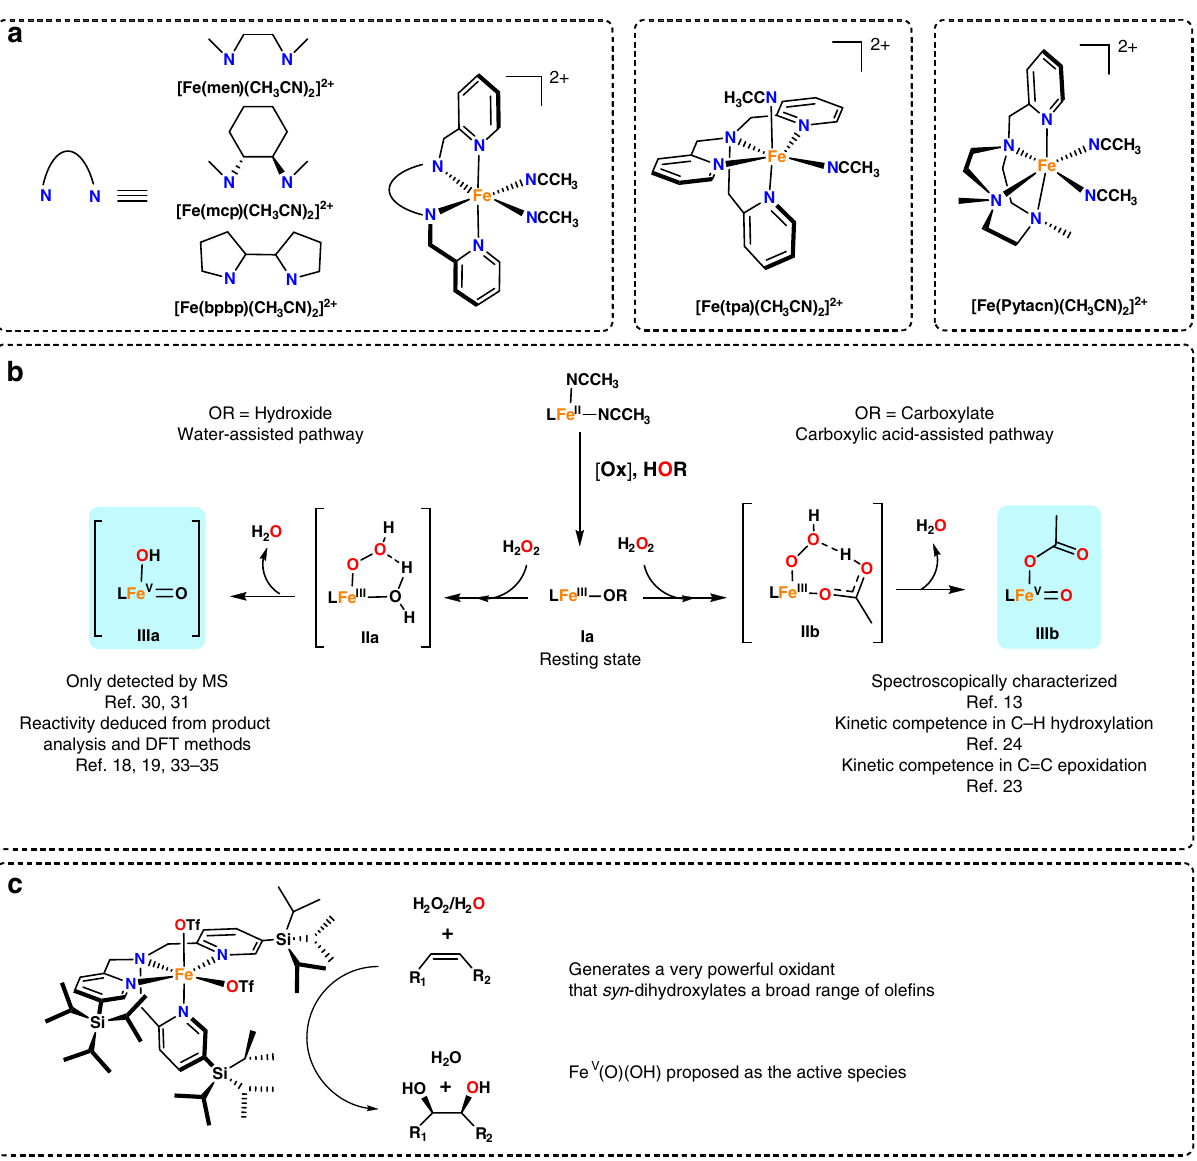
Fig. 1 Mechanistic frame of iron-catalyzed oxidations with tetradentate aminopyridine ligands. a Iron catalysts based on tetradentate aminopyridine ligands that catalyze stereoretentive C – H and C = C oxidations. b Mechanistic frame for the generation of Fe(V) species in the presence (right) or absence (left) of carboxylic acids. c Schematic diagram of [Fe II (CF 3 SO 3 ) 2 ( 5tips3 tpa)] ( 1 ) and its catalytic oxidation